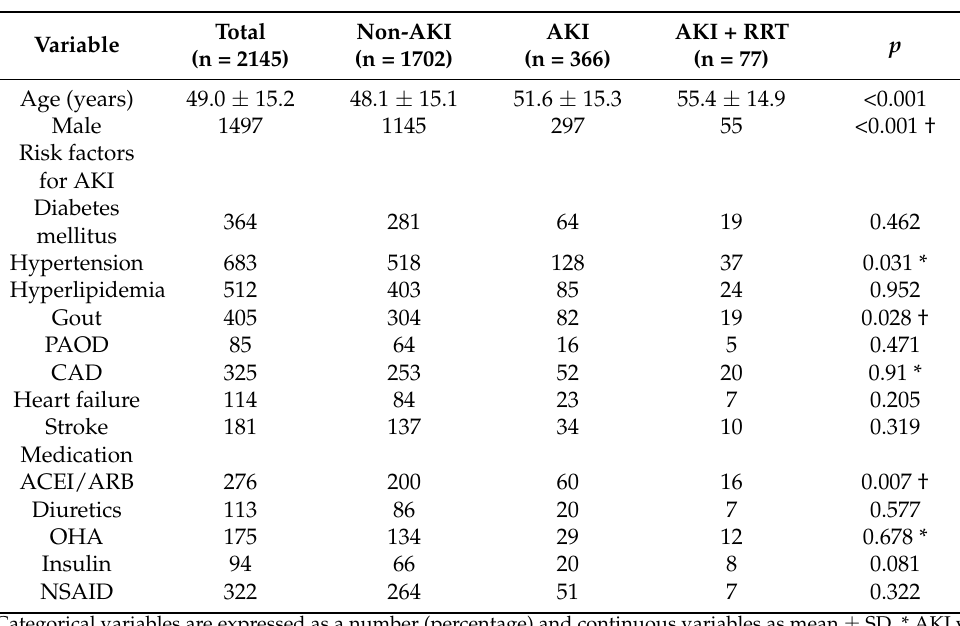
Table 1. Baseline patient profiles.